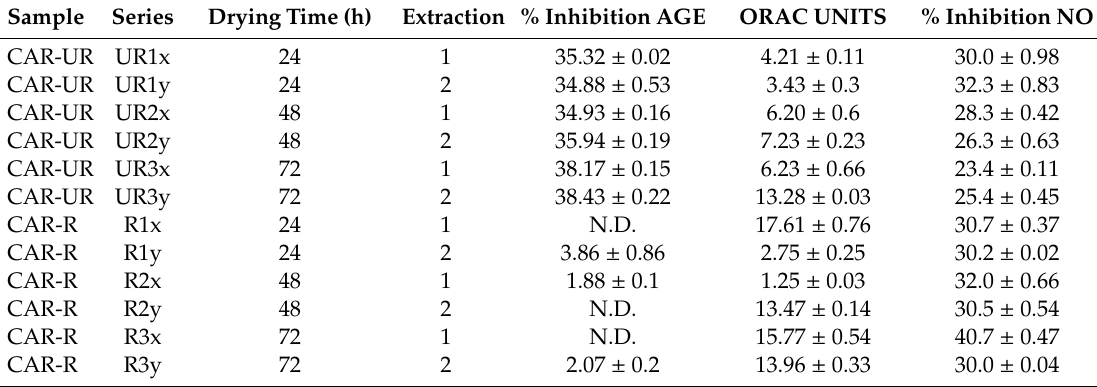
Table 2. Percentage of inhibition and antioxidant activity of CAR-R and CAR-UR